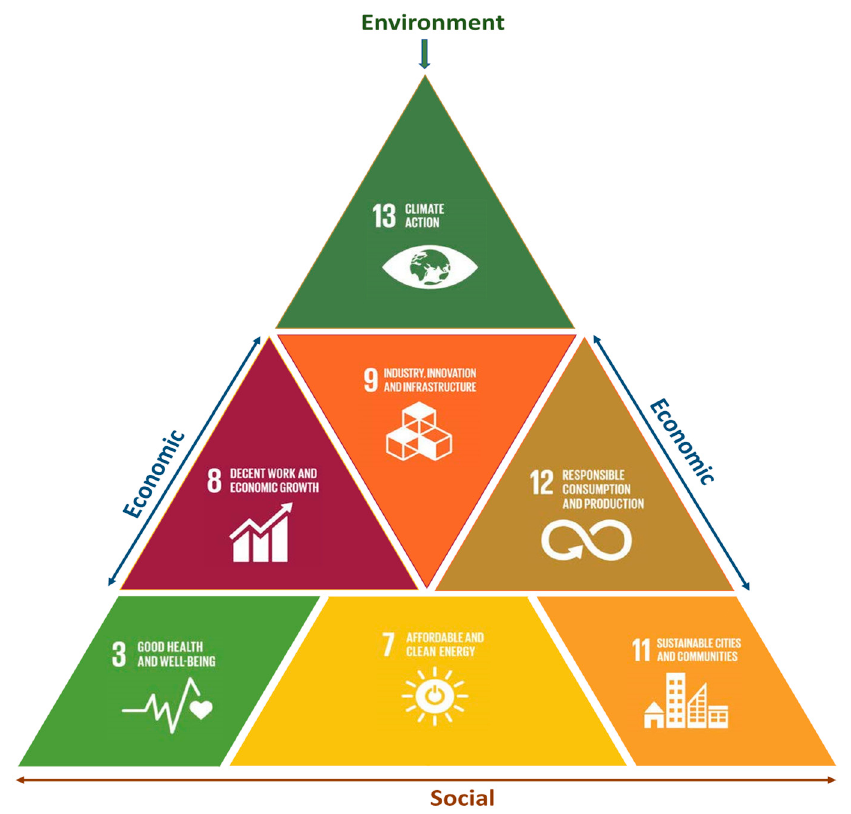
Figure 25. Association of EVs with SDGs.